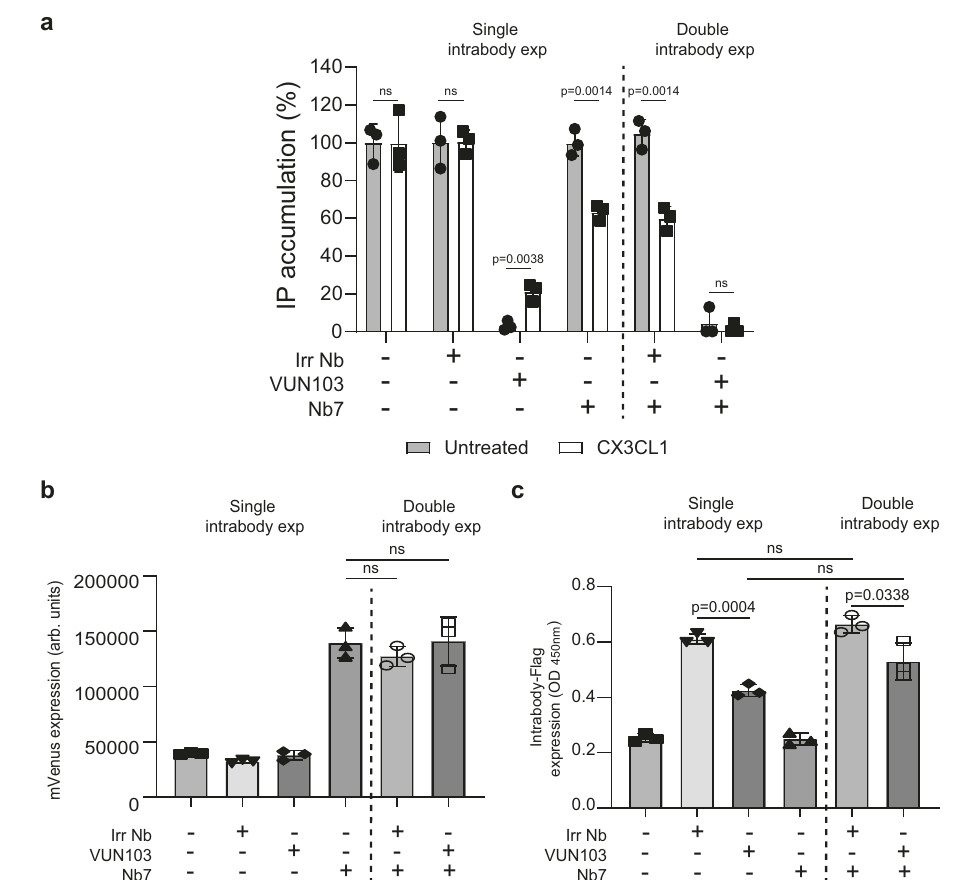
Fig. 6 VUN103 and Nb7 have opposing effect on constitutive and ligand-induced signaling. a Effect of non-US28 targeting FLAG-tagged intrabody (Irr Nb), FLAG-tagged VUN103 (VUN103), and/or Nb7-mVenus (Nb7) on US28-mediated accumulation of inositol phosphate (IP) in US28-expressing HEK293T cells that were untreated or stimulated with 30 nM CX3CL1 (CX3CL1). Expression of FLAG-tagged intrabodies was induced using 100 nM